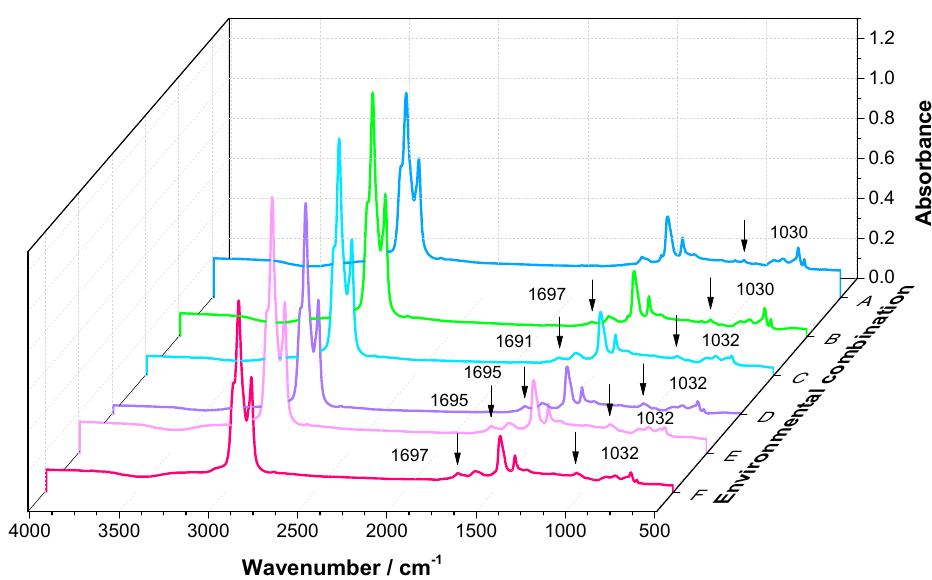
Figure 9. IR spectra of asphalt R under different environmental combinations.